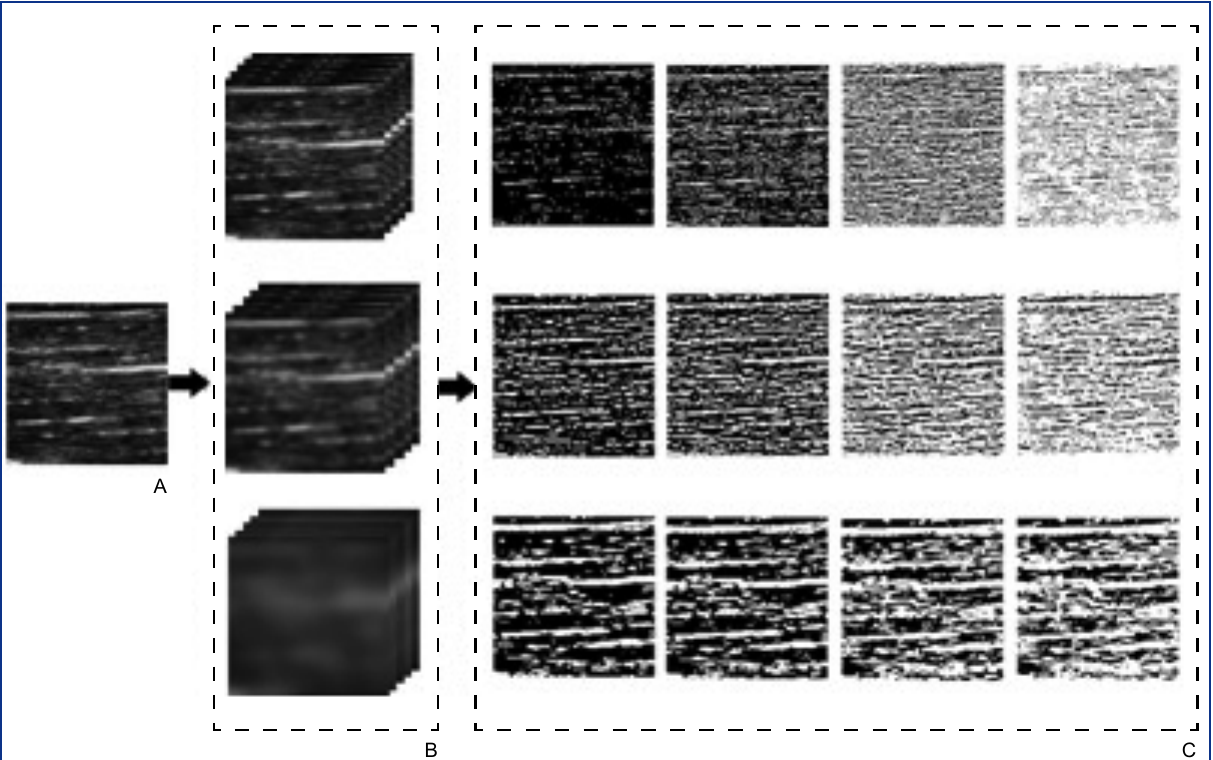
Figure 1 Schematic diagram of multistage decomposition process on skeletal muscle high frequency sonographic intensity interface. (A) Gray-scale sonogram of skeletal muscle; (B) Decomposition threshold images; (C) Intensity interface decomposed binary Table 2 Eight texture features of biceps brachii in male healthy volunteers under relaxation and contraction ( x ± s , n =30 samples) Parameters NOB HOD IRGL SOB DOD POD Mean SDev Relaxed state 1.93±0.53